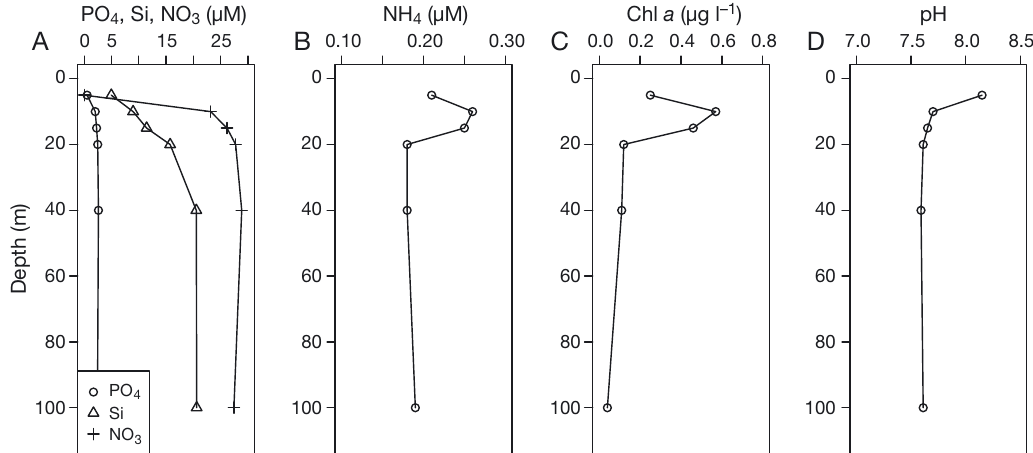
Fig. 6. Depth profiles of (A) phosphate (PO 4 ), silicon (Si) and nitrate (NO 3 ), (B) ammonium (NH 4 ), (C) chlorophyll a (chl a ) and (D) pH at a mid-fjord site close to the experiment site in the Comau Fjord,